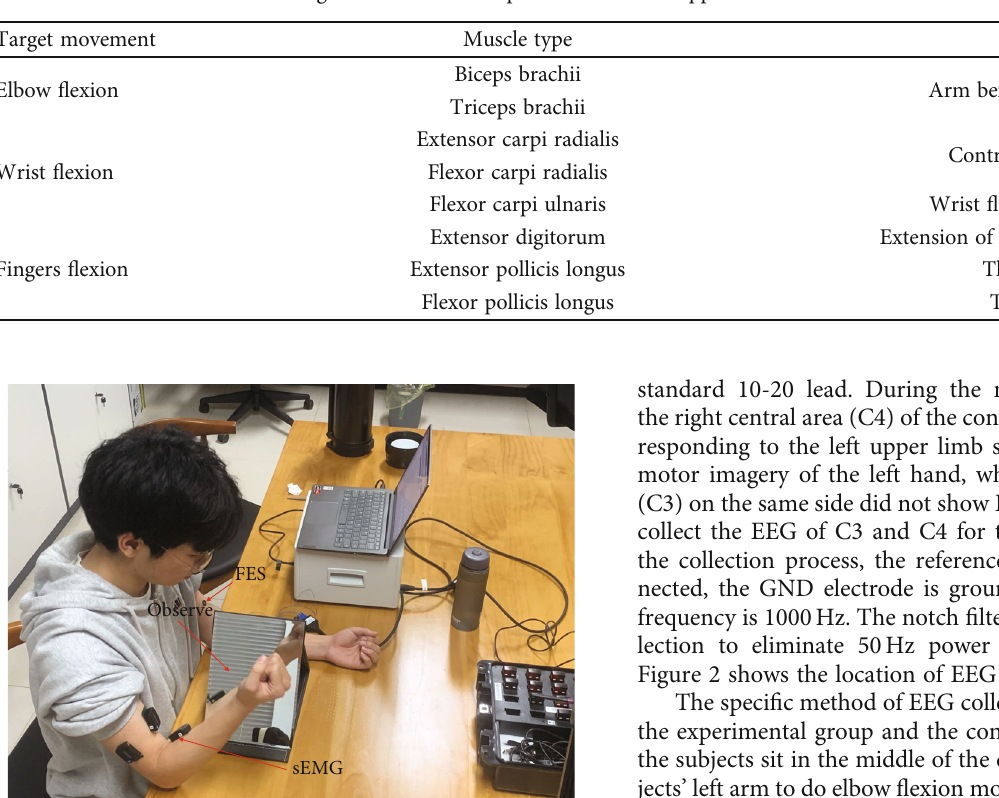
Table 1: Target movement corresponds to human ’ s upper limb muscles and their function.